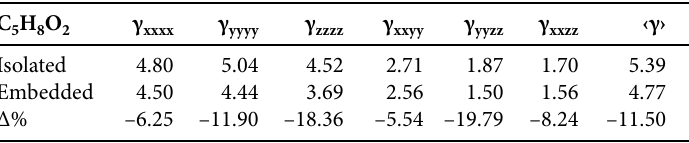
Table 2: CAM-B3LYP/6-311++G(d,p) results for the second hyperpolarizability (in 10 –36 esu ) in the static case.